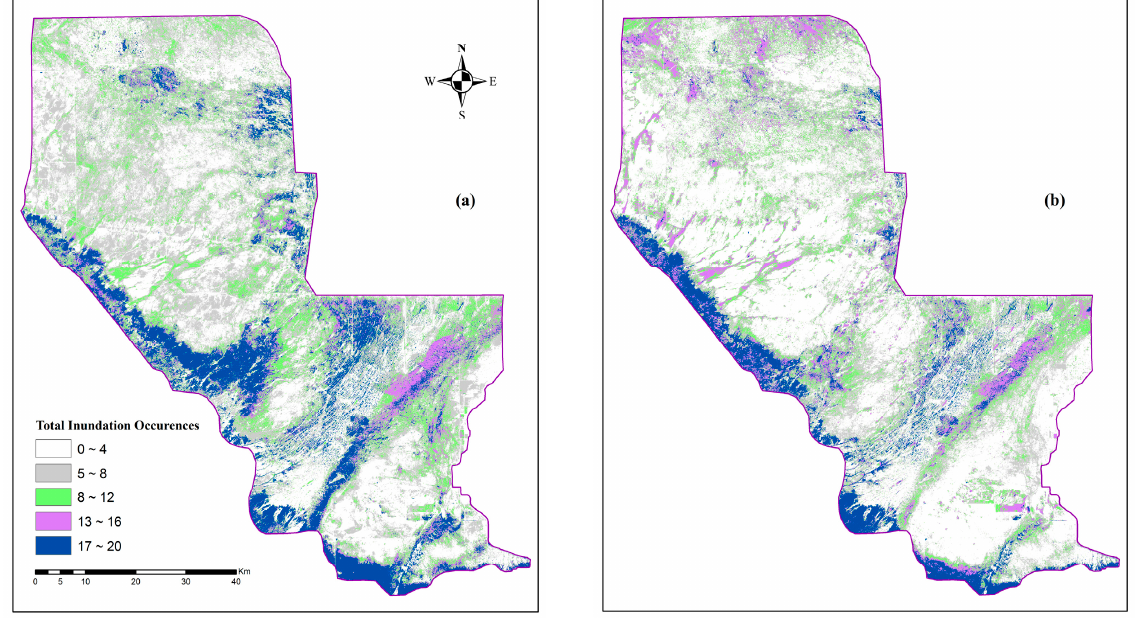
Figure 5. Total inundation occurrences in ( a ) wet season and ( b ) dry season from 2002–2021.